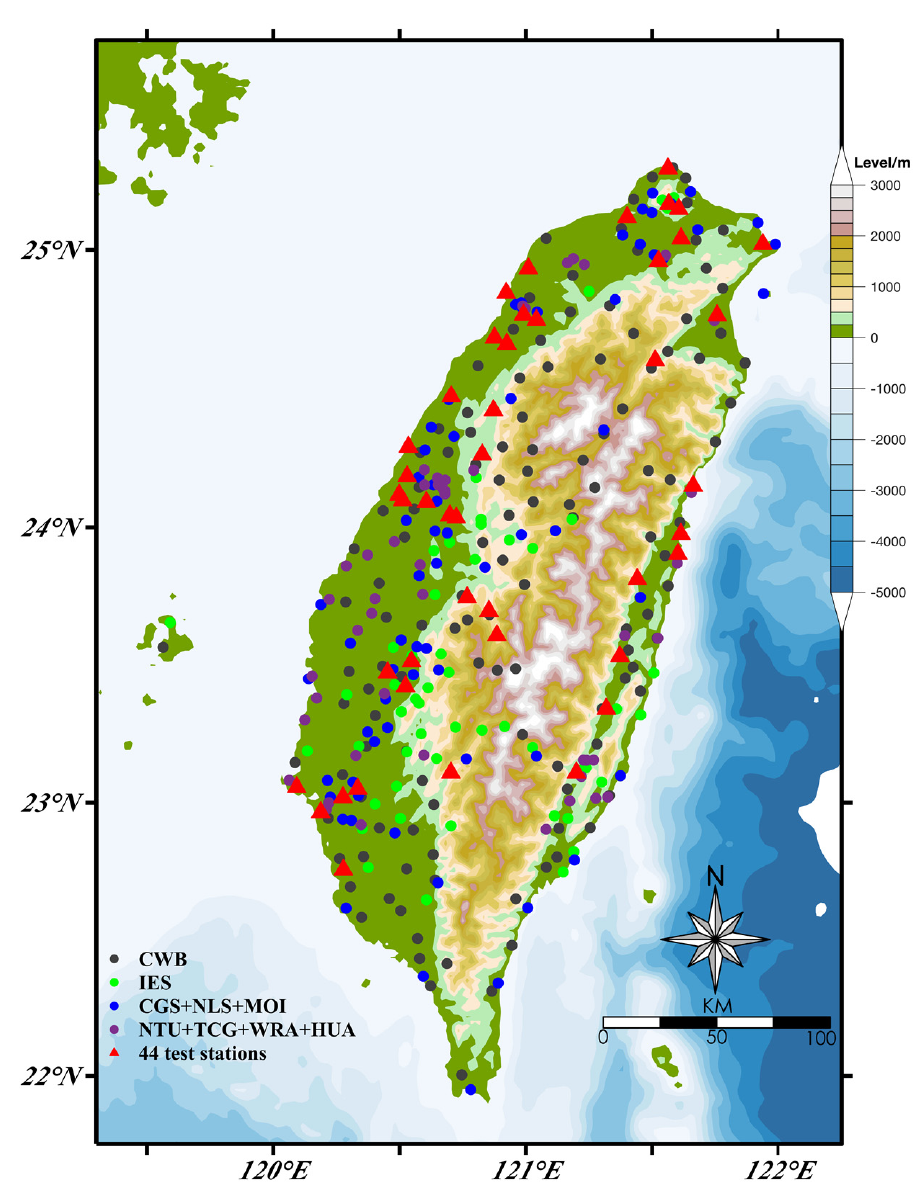
Figure 1. Taiwan continuous global positioning system (CGPS) network. The black, green, blue, and purple circles represent CGPS sites operated by the Central Weather Bureau (CWB), the Institute of Earth Sciences (IES), the Central Geological Survey (CGS) and the Water Resources Agency (WRA) and other research units. Among them, the sites represented by red triangles are used in this ICA/PCA study.